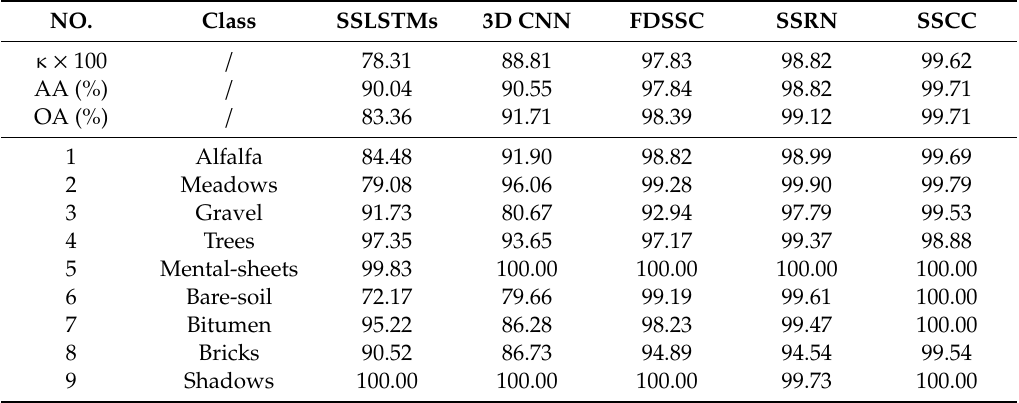
Table 3. Classification results of di ff erent methods for the University of Pavia dataset.